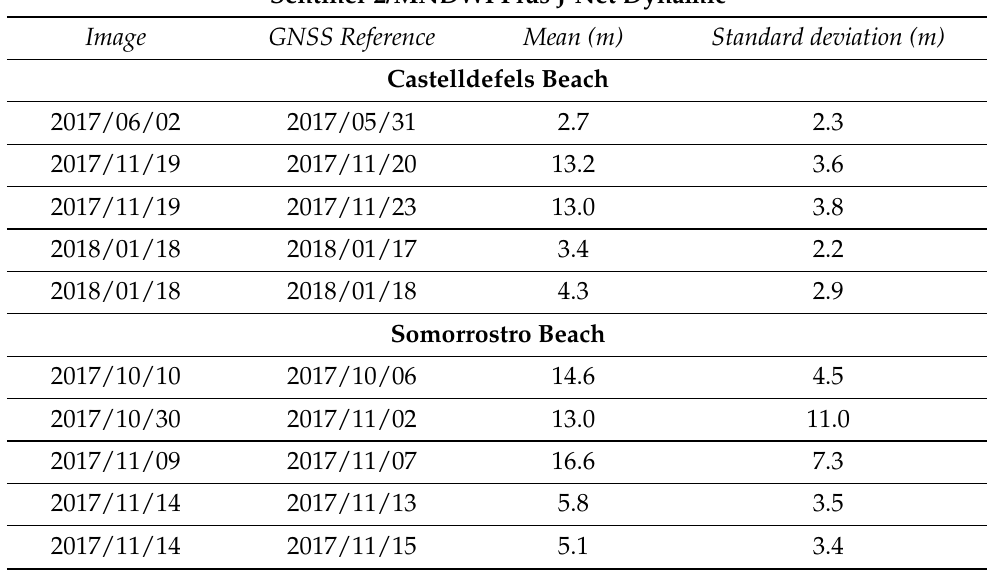
Table 8. Mean and standard deviation of the distances between Sentinel-2 shorelines and GNSS reference points in Castelldefels and in Somorrostro beaches by using at first the MNDWI and then the experimental J-Net Dynamic